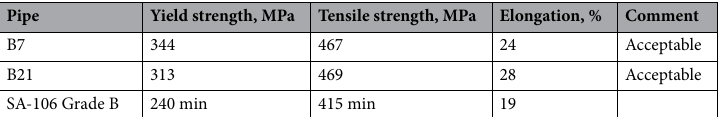
Table 6. Tensile properties of